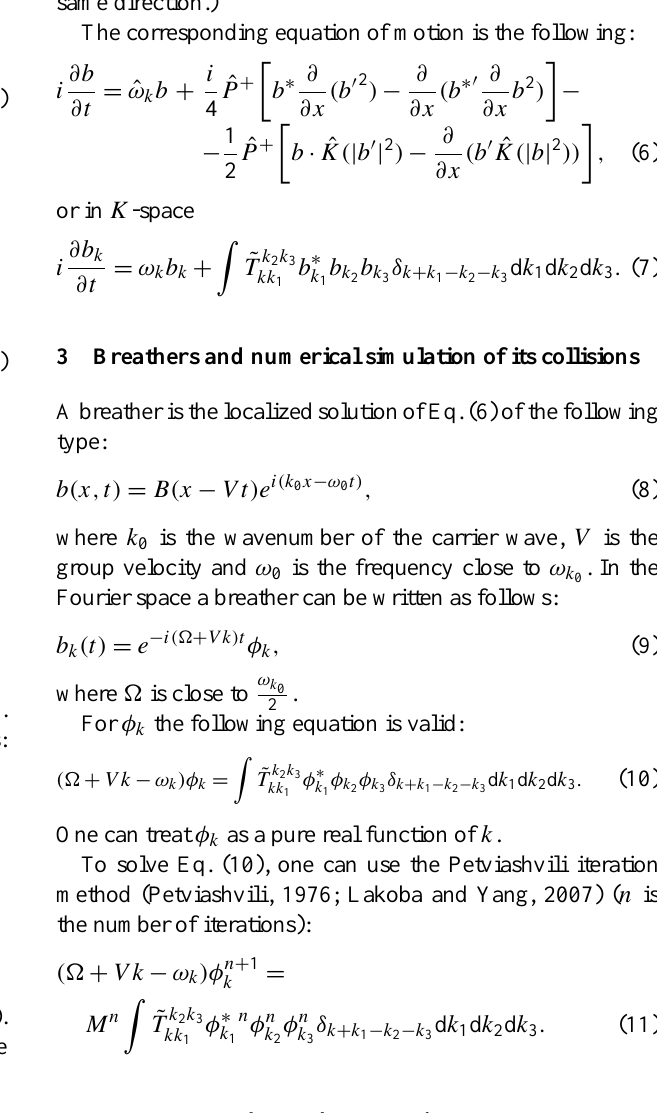
same Fourier spectrum of b ( x ). Modulus of b ( x ) coincides with the modulus of B ( x Vt ) if (3.8) and is similar to the wave en- − velope if we derive Nonlinear Schroedinger Equation from (2.6).